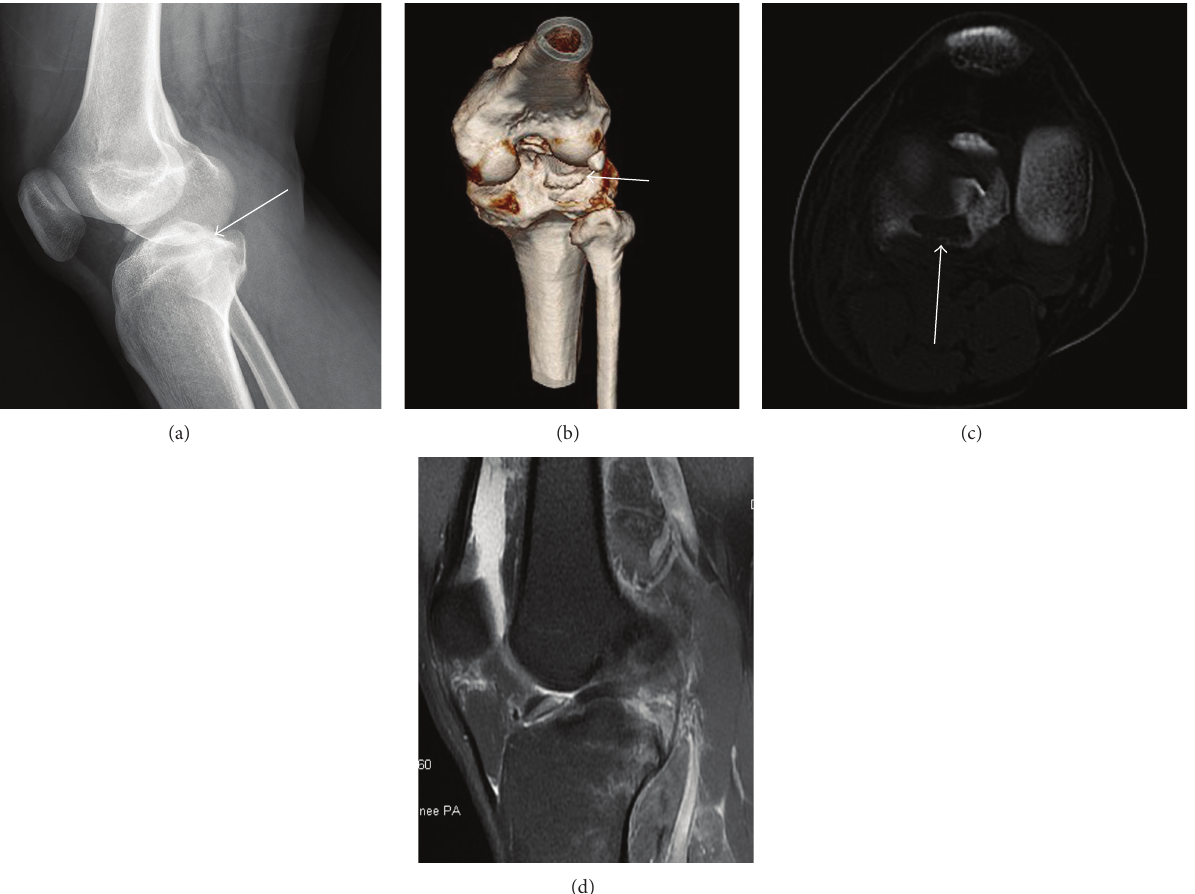
Figure 2: Imaging examinations of the second patient. The X-ray image (a) shows a posterolateral tibial plateau fracture (white arrow). In the CT scans (b and c), a cavity was formed at the lateral location of posterolateral tibial plateau fracture (white arrow). In the MRI image (d), ACL rupture and lateral meniscus tear were confirmed. Other ligaments were not found by the MRI